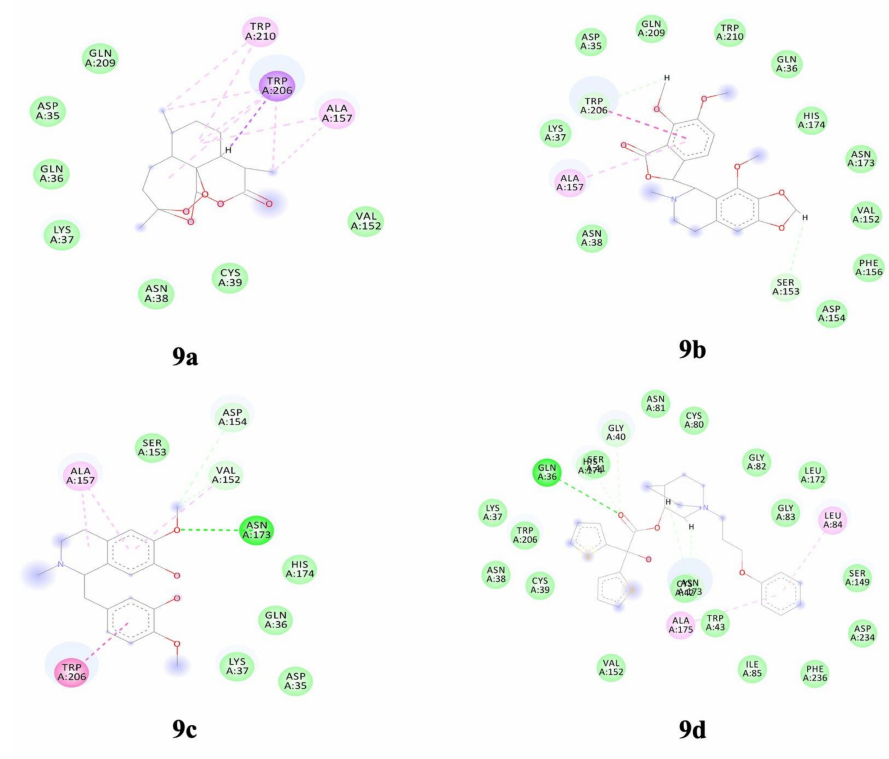
Figure 9. Interacting residues between falcipain-2 and alkaloids ( 9a ) Artemisinin ( 9b ) Noscapine ( 9c ) Reticuline ( 9d )